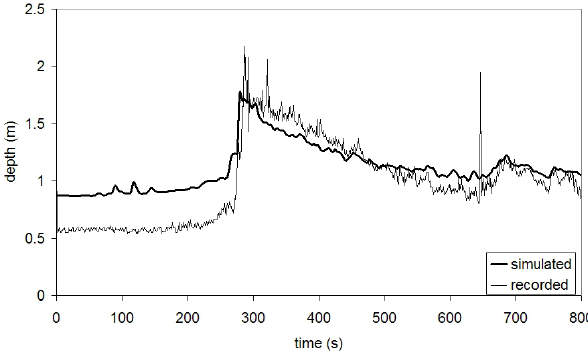
Fig. 5. Comparison of recorded and simulated hydrograph (simula- tion performed with 1x =1m; 1t =1s) at the downstream reach.